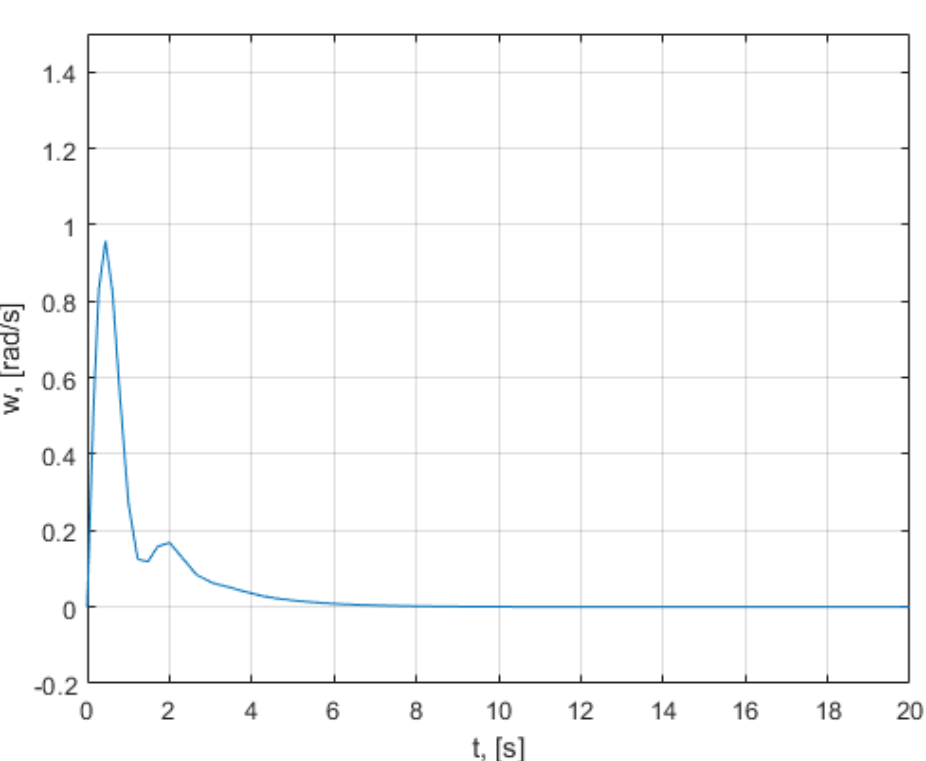
Figure A4. The speed response of position control system.